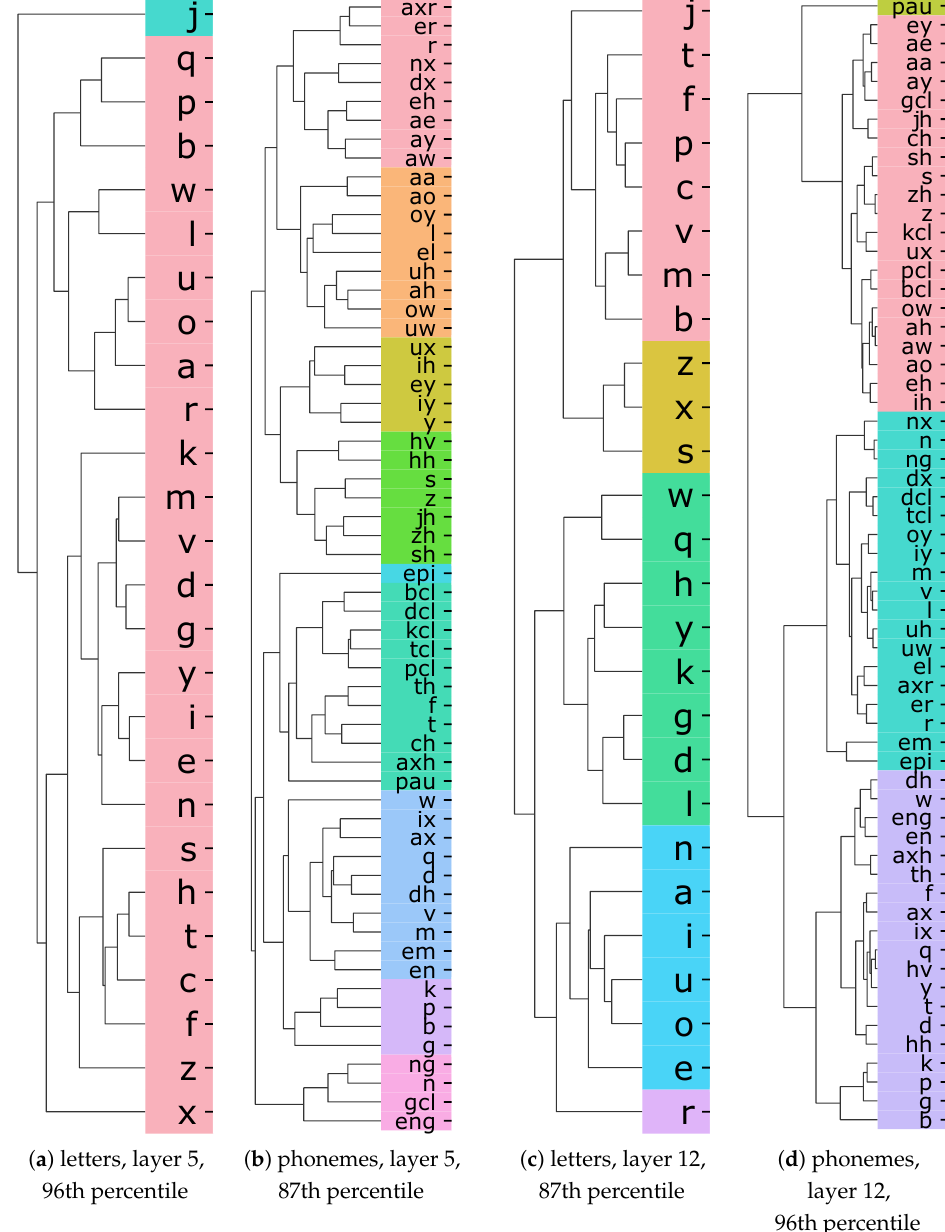
Figure 10. Clustering result of SNAPs of the W2L model in layers 5 and 12 using grouping by predicted letter and annotated phoneme. Each subfigure shows the clustering at the respective percentile of best clustering quality according to Silhouette score. Clustering assignment is shown by coloring. Colors of clusters in different subfigures do not represent mapping of the corresponding clusters. Pairwise distances are visualized in Figure